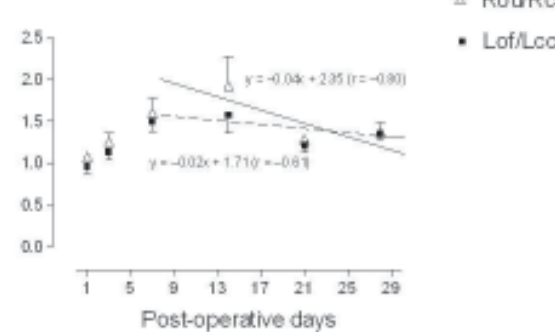
FIGURE 6- Ratios of 99m Tc-MDP uptake in tibiae of rats. The straight lines represent the linear regression calculations of the descending part of the curves. Dashed line refers to right tibial (with unfilled defects) values; solid line refers to the left tibial (with defects filled with freeze-dried bone) values. The tracer ( ca. 500 mCi) was injected i.v. and the animals were sacrificed 2 h later. Abbreviations: see legend to Fig. 2. Values are mean ±